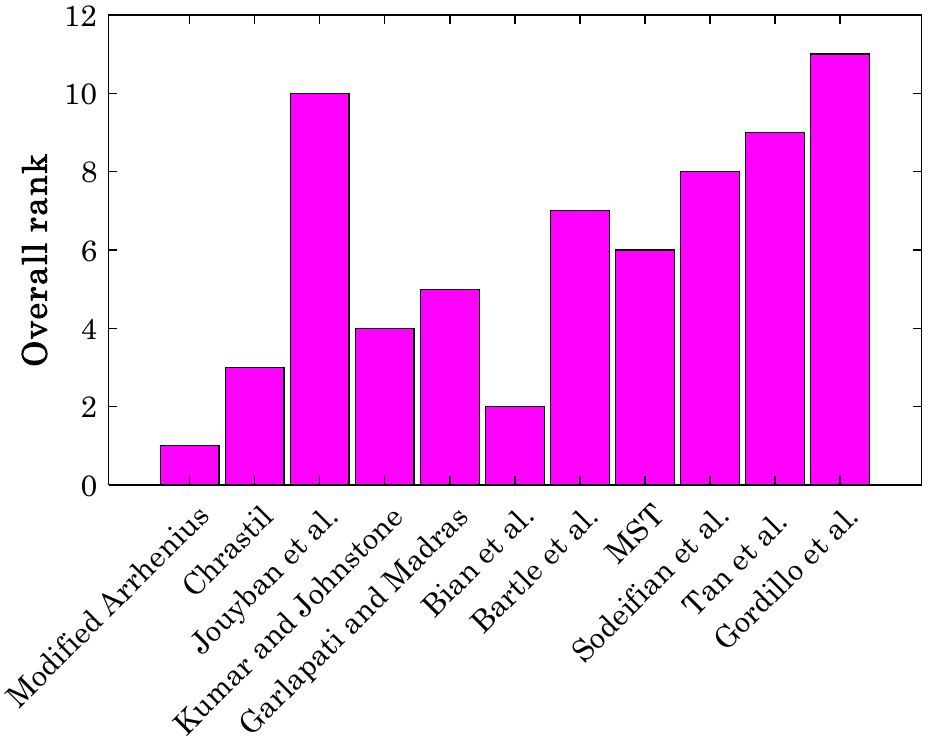
Figure 6. Overall ranking of the considered correlations to predict the solubility of anti-cancer drugs in supercritical carbon dioxide.